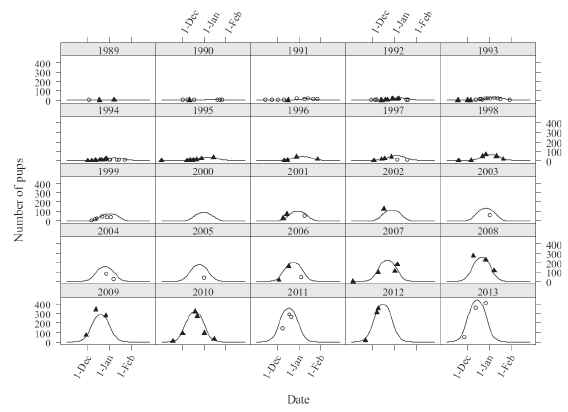
Figure 3. Wadden Sea grey seals: Observed ( ▲ , ○) and estimated (line) number of pups by month and year. Triangles ( ▲ ) represent the observed pups used to estimate model parameters, open circles (○) represent the number of pups observed after an extreme tide event (>2 m NAP). These data were excluded when fitting the population